Question: Summarize what this figure shows in one sentence.
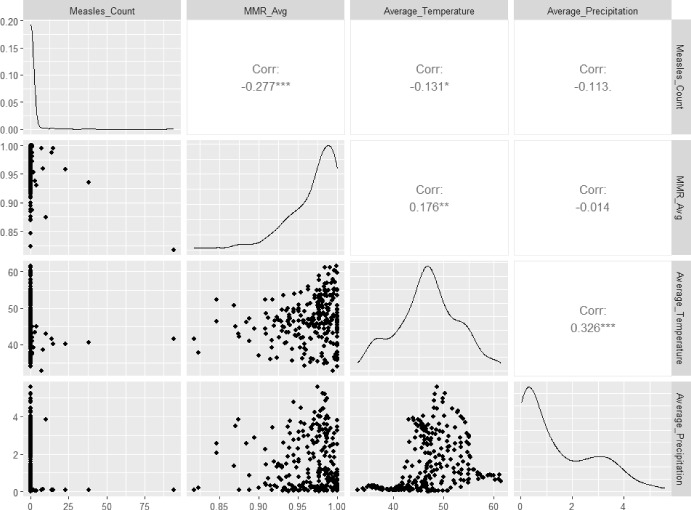
Answer: Scatterplot showing the relationships in the data in 2025